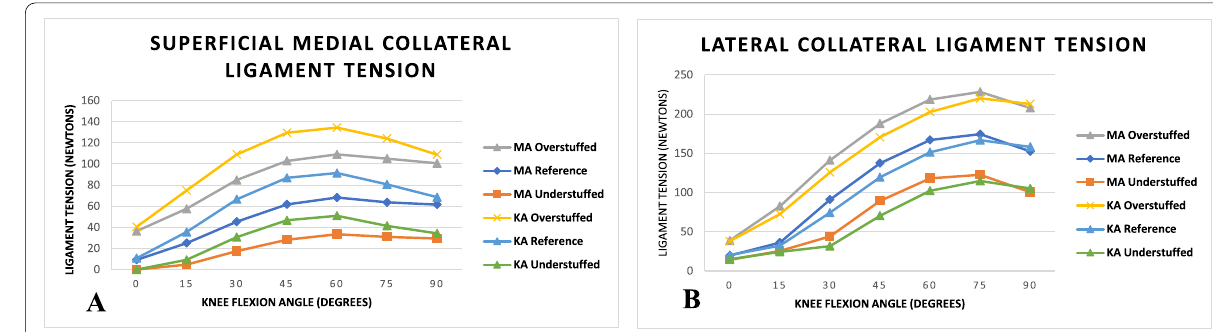
Fig. 2 Graphs demonstrating the relationship between ligament tension and polyethylene insert thickness. A Superficial medial collateral ligament, B Lateral collateral